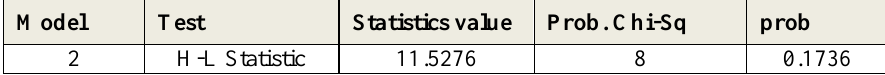
Table 8. Goodness-of-Fit Evaluation for Binary